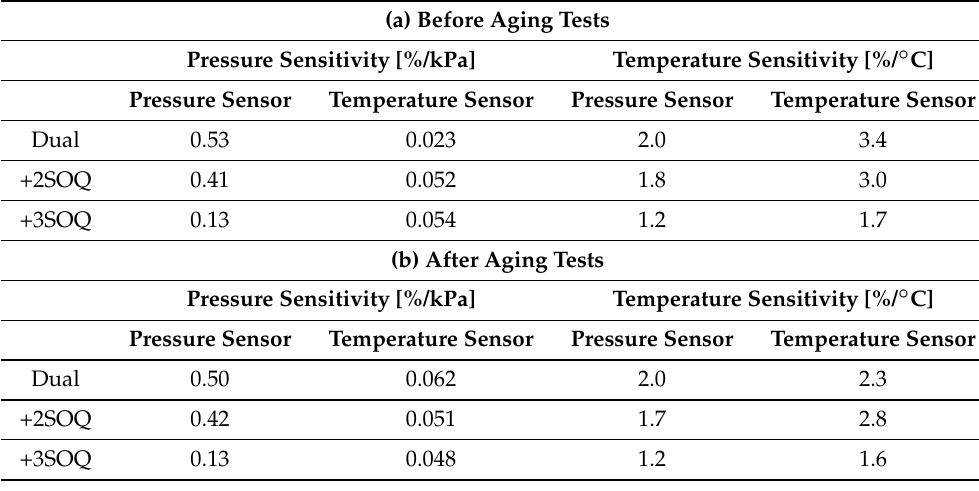
Table 5. Pressure and temperature